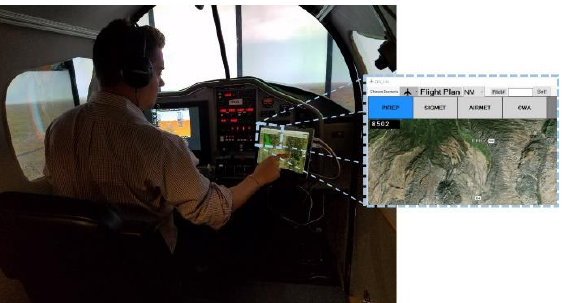
Figure 3. Weather and map display tablet in the cockpit. The arrival of a new weather message is indicated by the associated soft button highlighting in blue. Touching the soft button would open/close a pop-up text window that included the full text of the message.